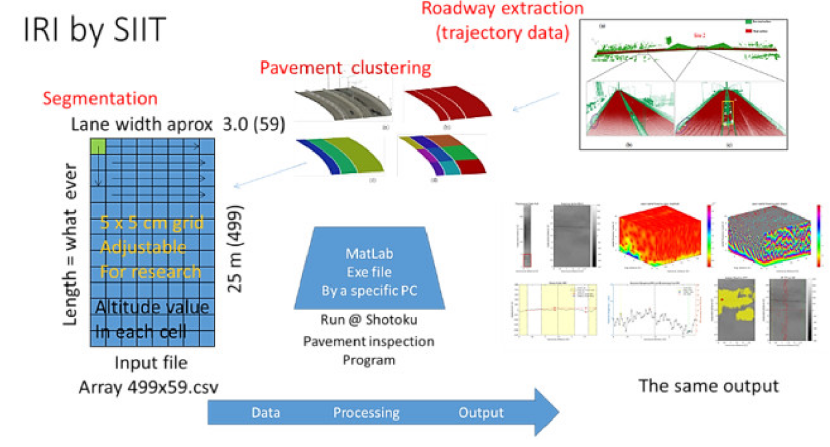
Figure 8. Working process for Expressway IRI calculation.